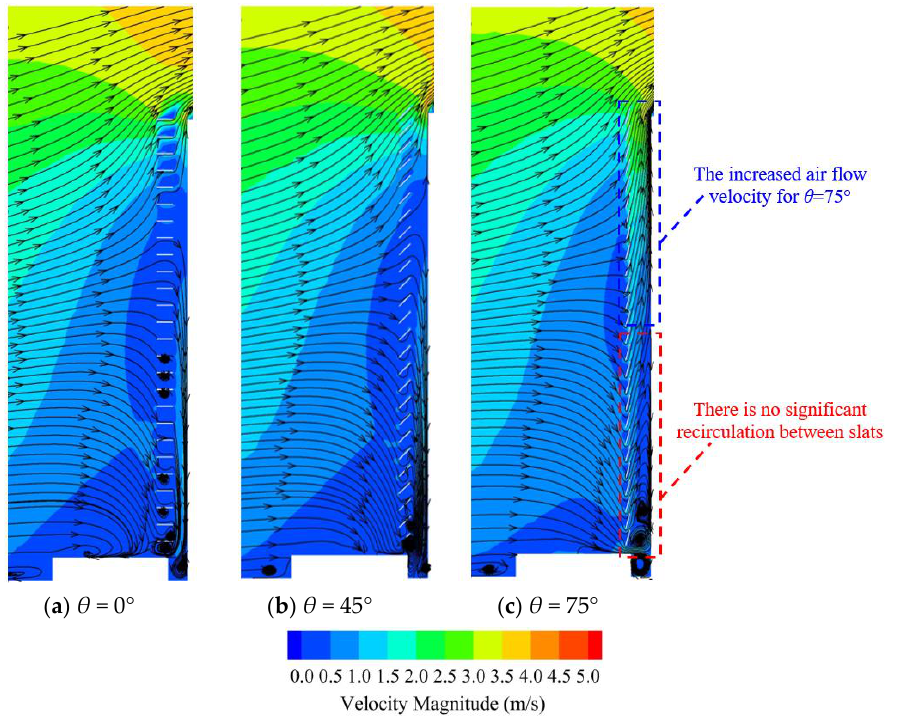
Figure 13. The flow patterns around the building façade with different louver angles θ ( U ref = 3.41 m/s, D = 0.05 H , B / H = 0.035, T H − T a = 10 °C, T B − T a = 20 °C, φ =